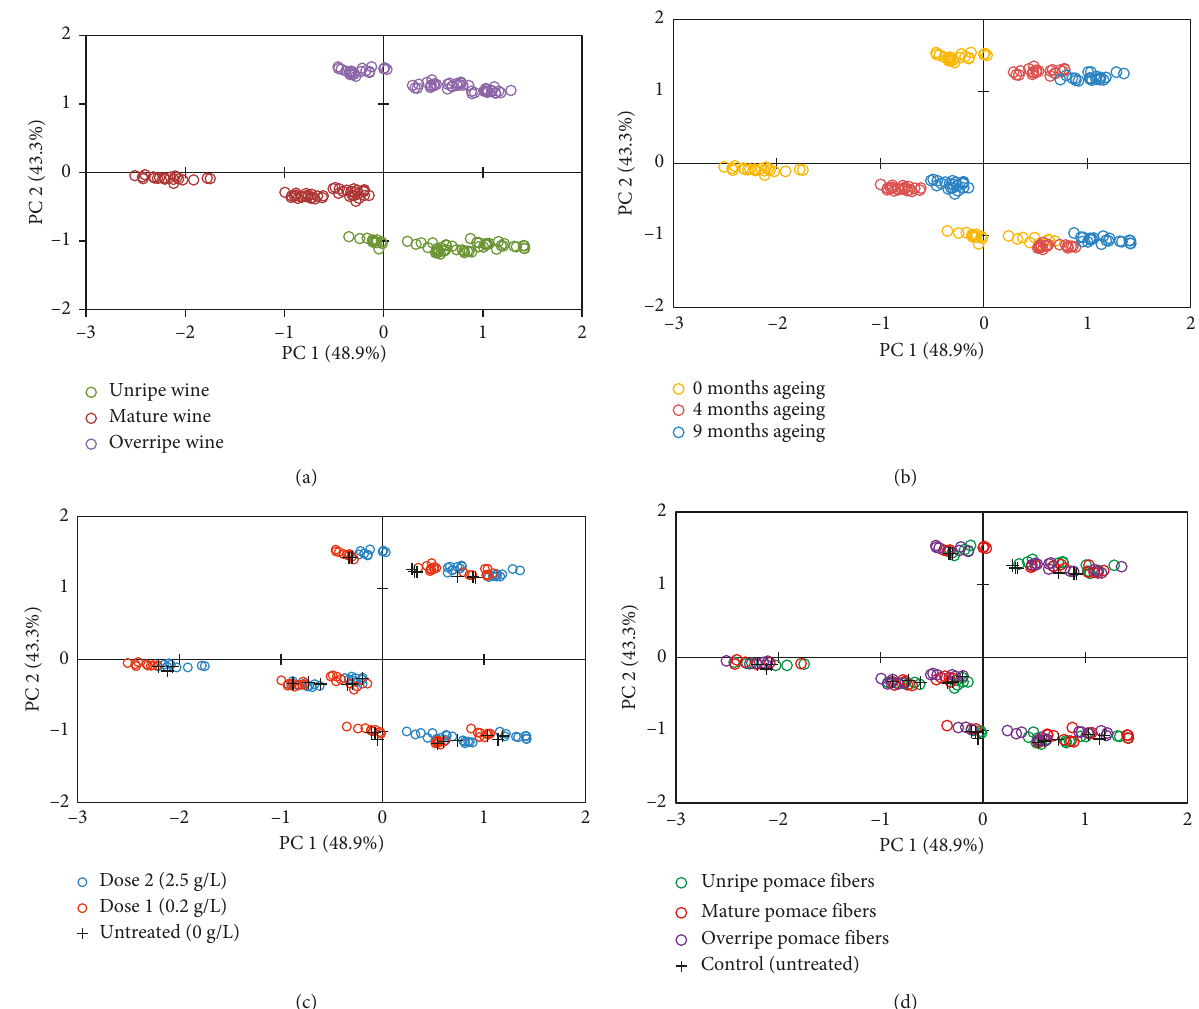
Figure 1: Principal component analysis (PCA) scores for the analyzed wines. Markers depicted as a function of the maturity of the grapes used for winemaking (a), the bottle ageing time (b), the dose of fibers applied (c), and the maturity of the grapes used to obtain the fibers from grape pomace